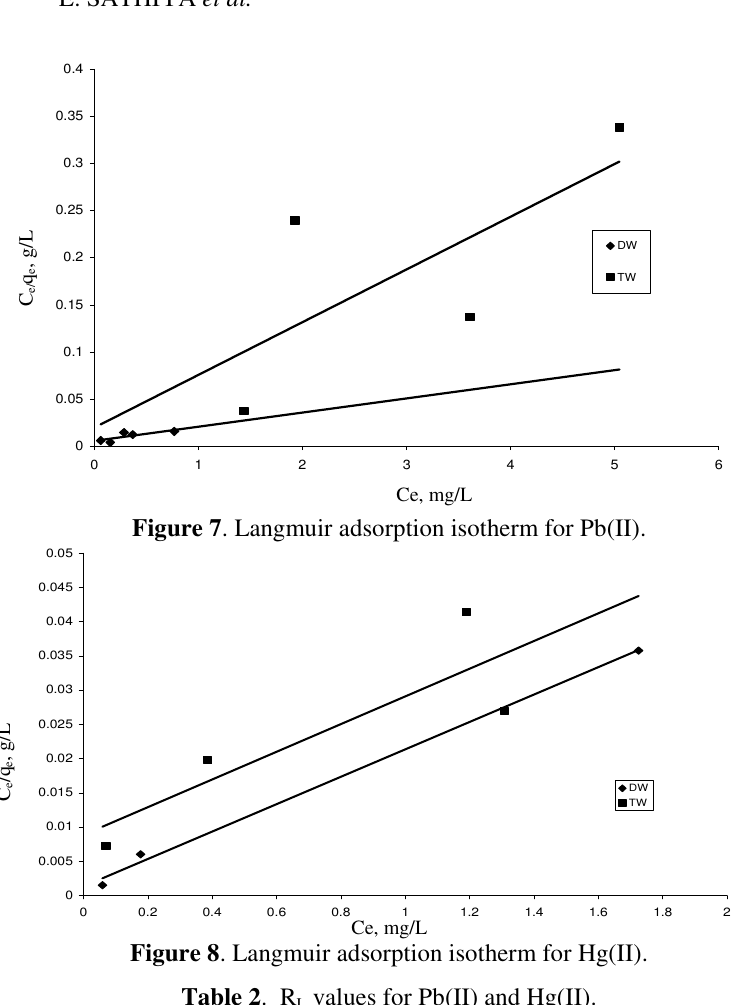
values (Tap water) L